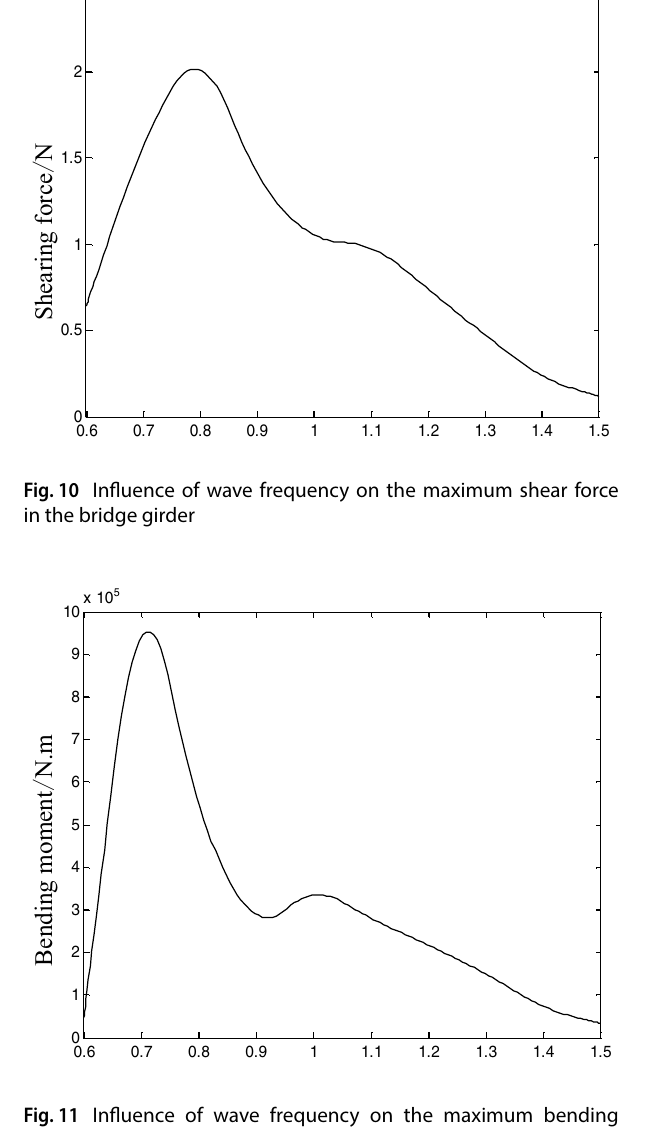
Fig. 11 Influence of wave frequency on the maximum bending moment in the bridge